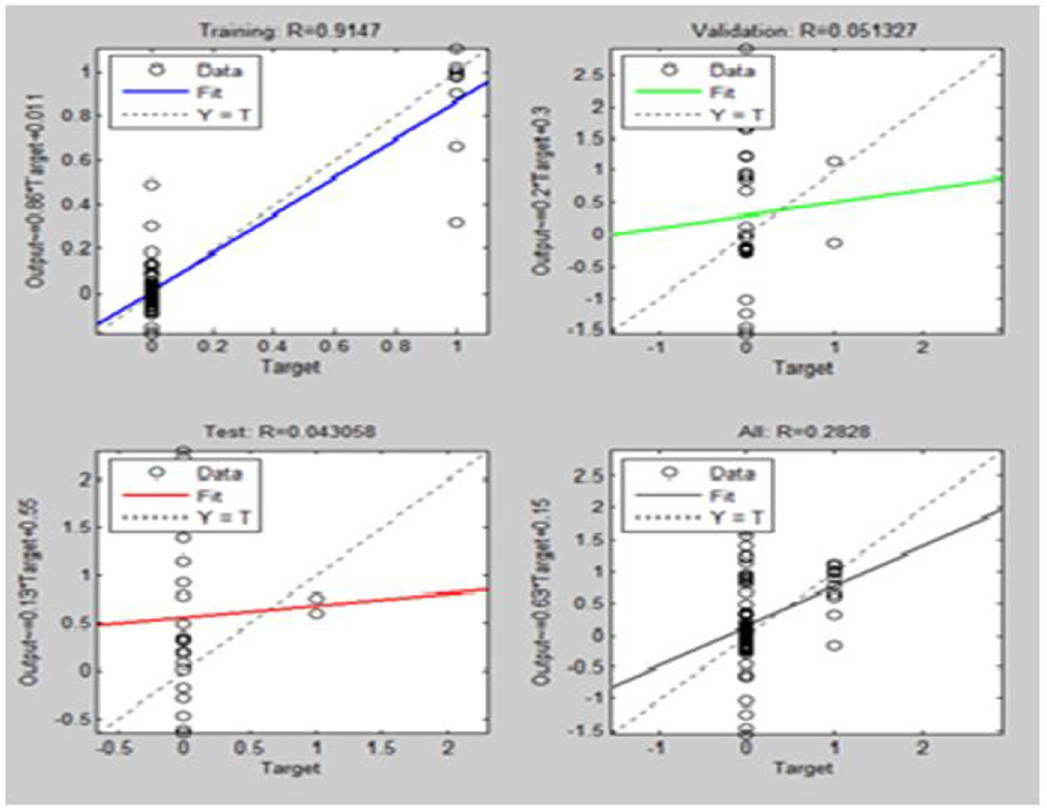
Figure 7: Regression analysis chart.